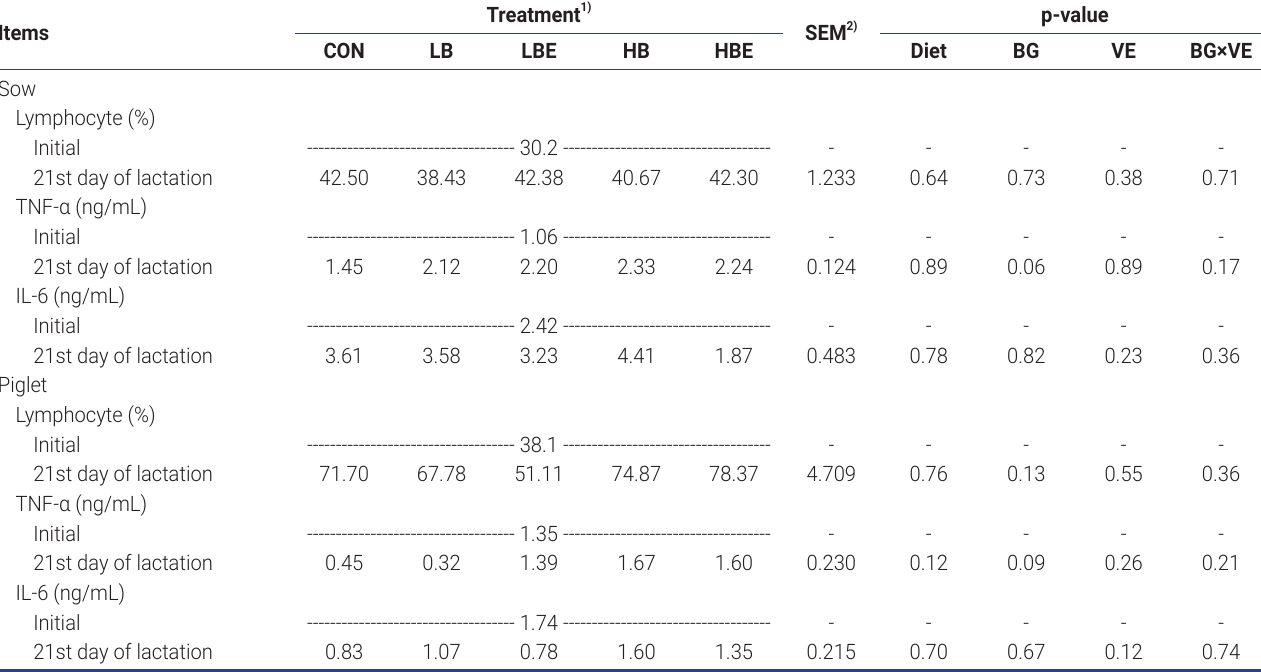
Table 5. Effects of β-glucan with vitamin E supplementation on the immune response in lactating sows and piglets